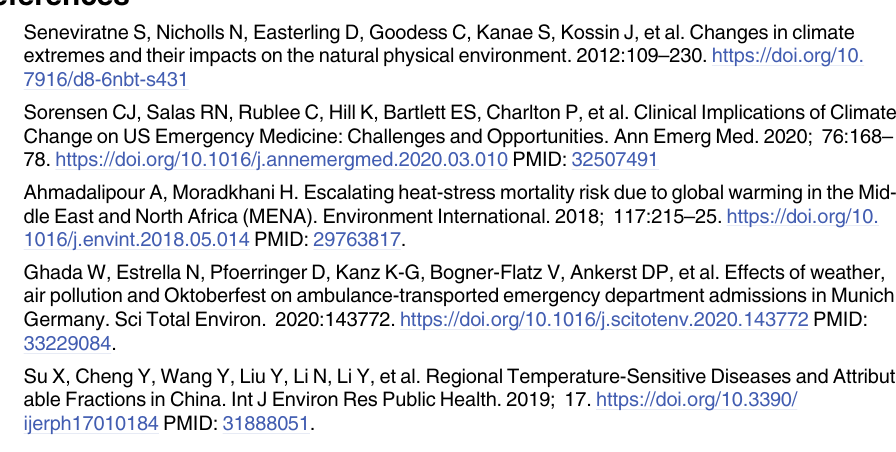
S1 Table. Percentages of hospital admissions, mortality, and road accidents in regions and by